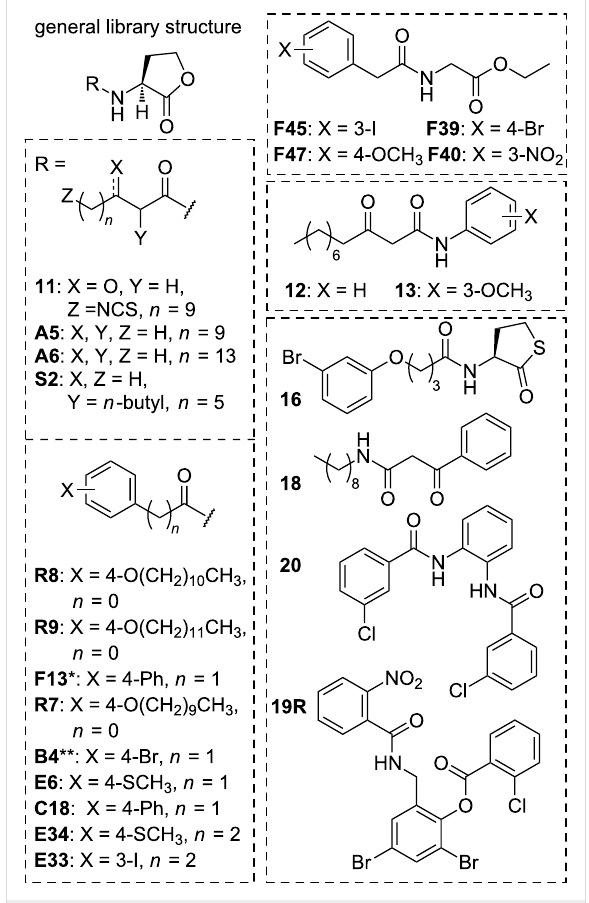
Figure 4: Chemical structures of the most potent SdiA antagonists. Compound names preceded by letters match those reported in our prior publications. * Indicates an L-thiolactone head group. ** Indicates a D-lactone head group. Compounds within each cluster (indicated by hashed line box) are listed in order of highest to lowest efficacy (maximal